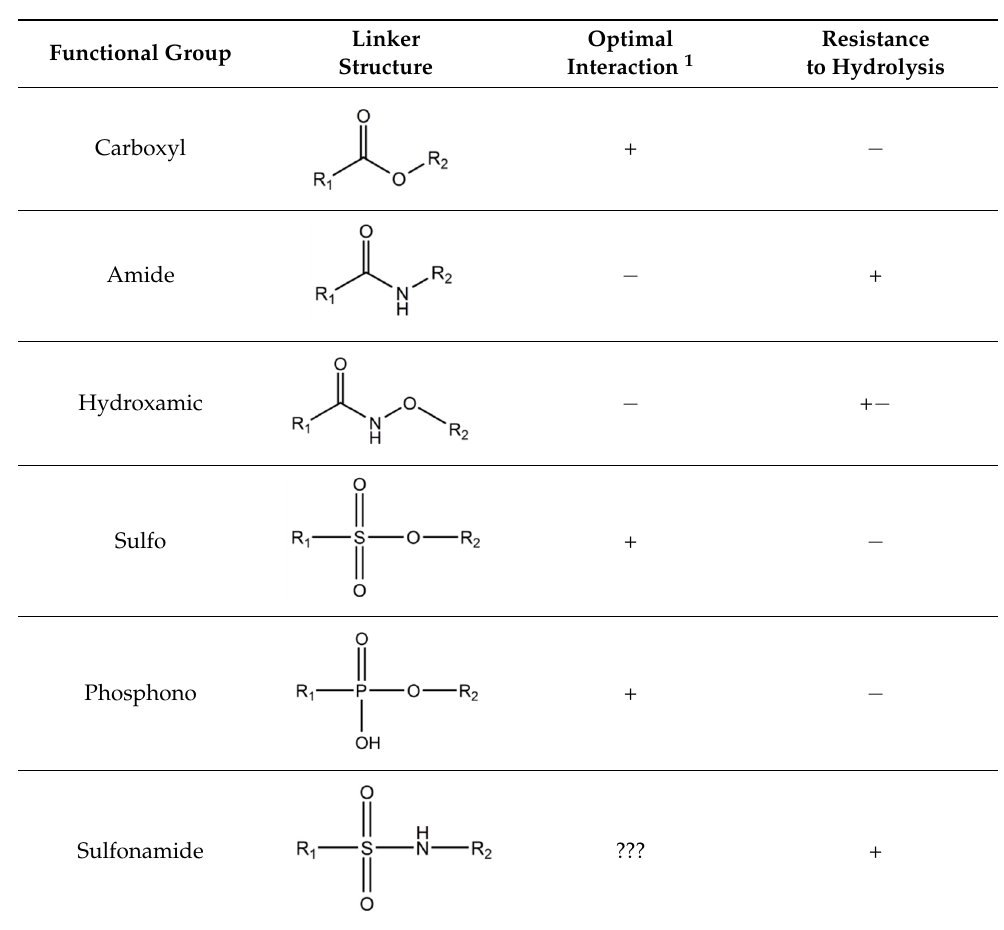
Table 1. Functional groups that can be used to construct a linker in a bifunctional neuraminidase